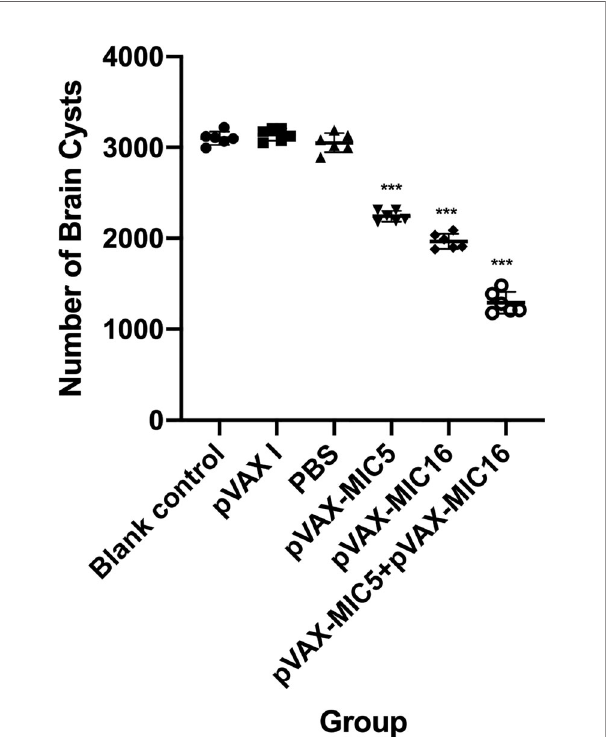
FIGURE 6 | Protection against chronic toxoplasmosis in immunized mice 2 weeks after the fi nal booster immunization. The bars represent the mean cyst burden per mouse brain after oral challenge with 20 cysts of the PRU strain. Cyst load was determined from whole brain homogenates of mice 4 weeks after challenge. Data are means ± SD (representative of three experiments). *** p < 0.001, compared with the control